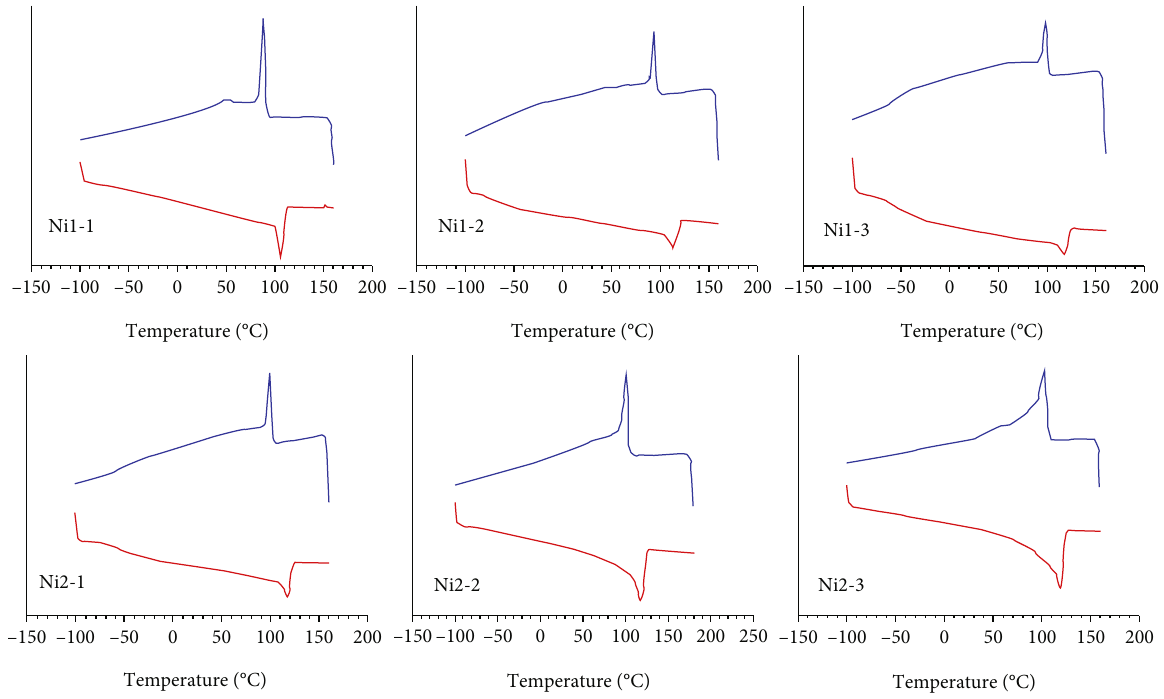
Figure 6: DSC scans for melting and cooling from the melt through polymerization condition